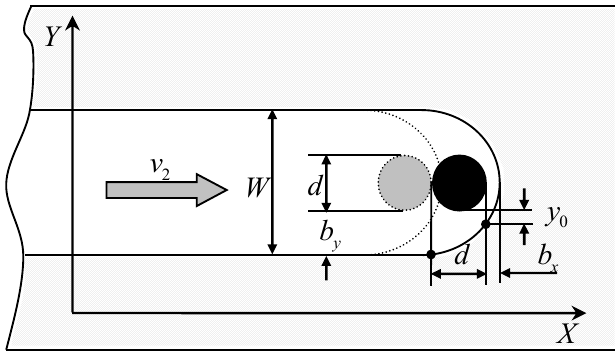
Figure 2. Micro-electrochemical milling in the XY plane.